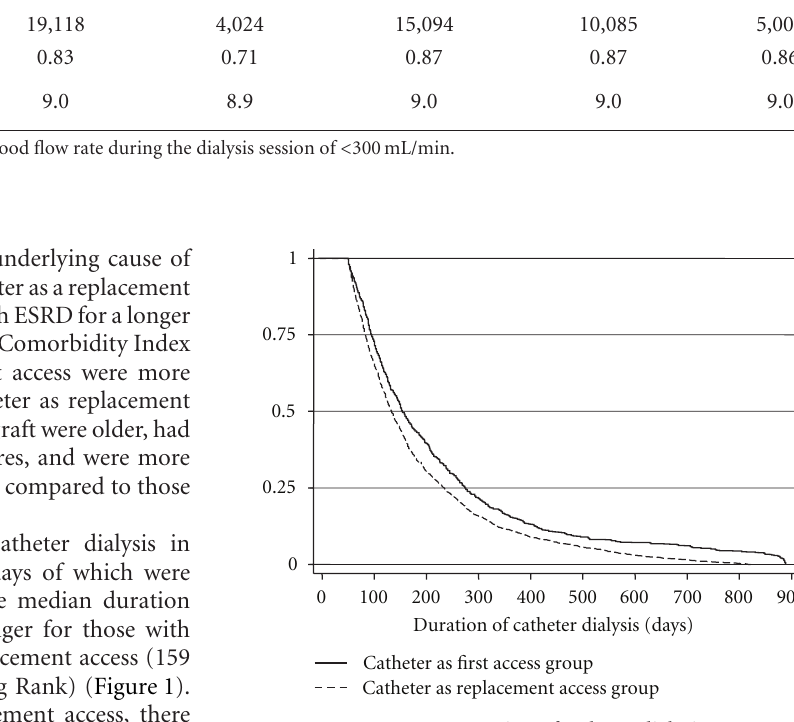
Figure 1: Duration of catheter